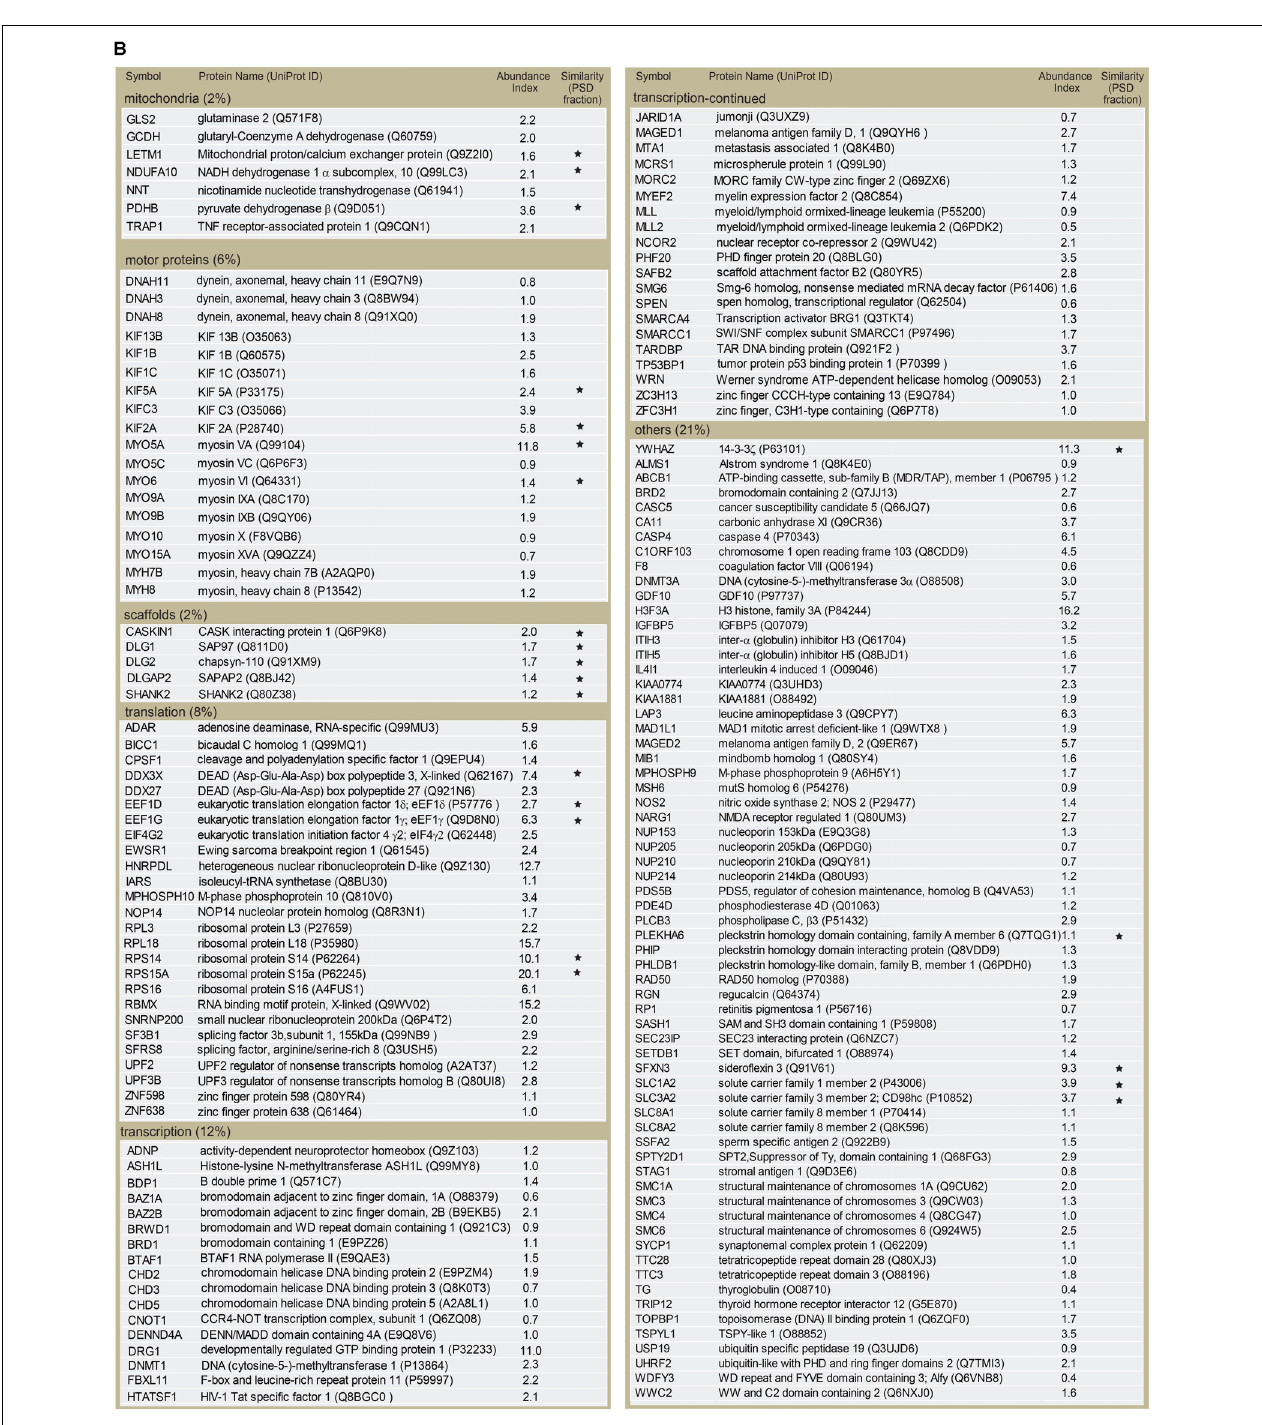
FIGURE 3 | Classification of proteins identified in the dendritic phagocytic cups. (A) Pie chart showing functional categories of the proteins in the dendritic phagocytic cups. Axon guidance (1%), cell adhesion and ECM (4%), channels and receptors (2%), cytoskeleton-actin (8%), cytoskeleton-others (7%), chaperone (1%), GTPase and regulators (8%), kinase and phosphatase (11%), membrane trafficking (7%), metabolism (3%), mitochondria (2%), scaffolds (2%), transcription (12%), translation (8%), and others (21%) are shown. (B) Protein components in the dendritic phatocytic cup fraction. Symbol, protein name, UniProt ID, abundance index, and similarity with the 984 proteins in mouse PSD fraction described by Bayes et al. (2012) are indicated in the table. An abundance index for each protein was calculated from number of fragments detected by LC-MS/MS and normalized with molecular weight. The proteins identified in both dendritic phagocytic cup and PSD fractions are marked with